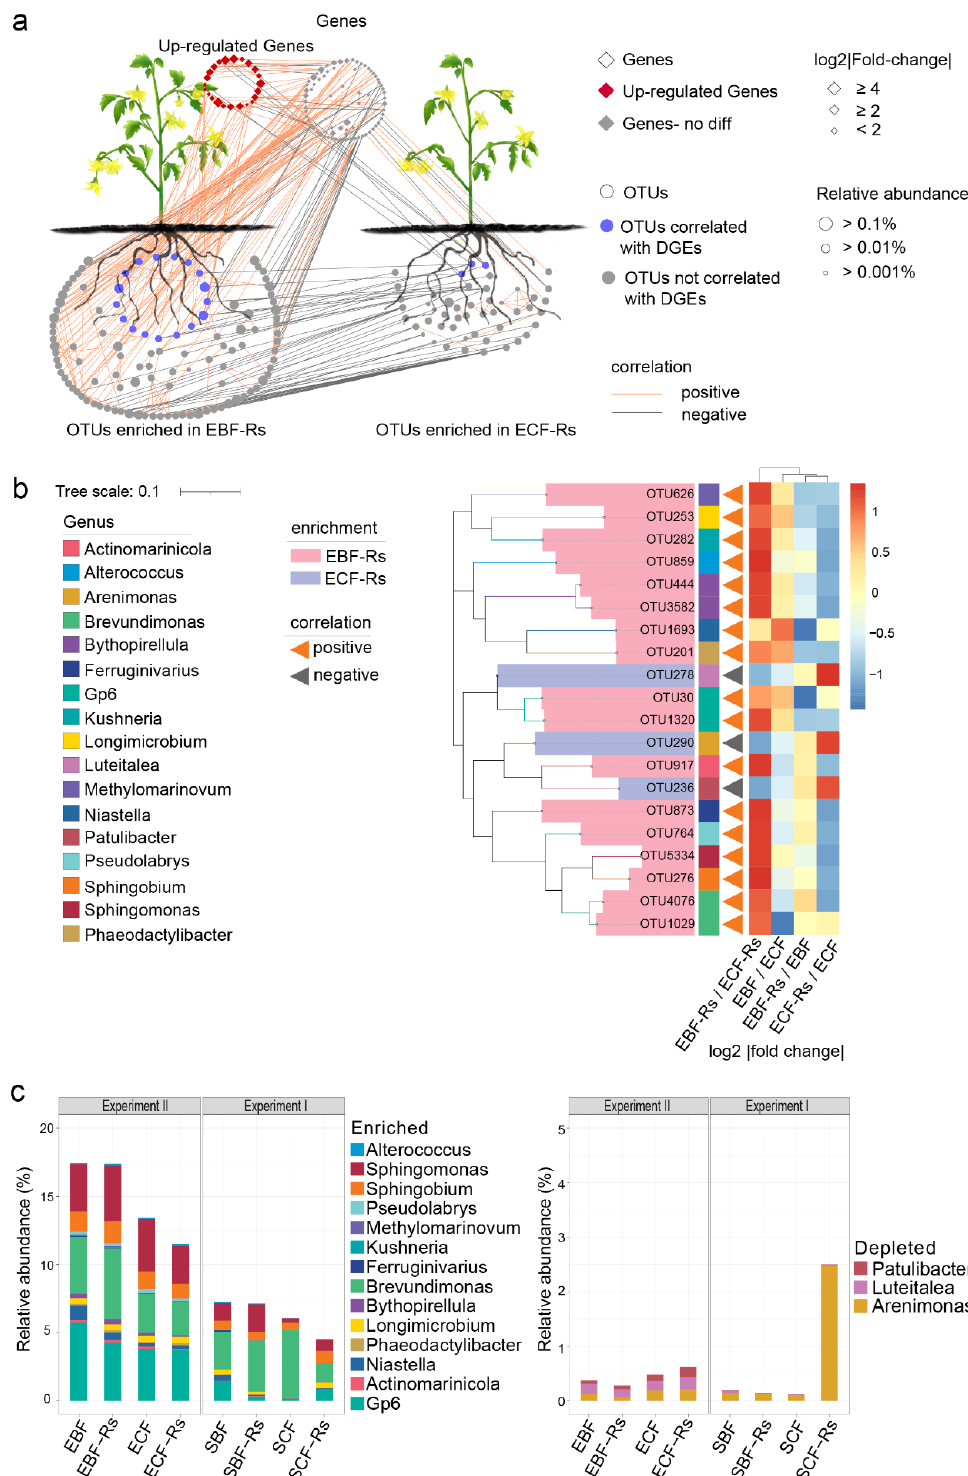
Figure 5. Correlational analysis between microbial taxa and root gene expression. ( a ) Network analysis displays all possible correlations between OTU × OTU, OTU × gene, and gene × gene (all 143 genes in phenylpropanoid biosynthesis pathway and all enrichment OTUs in EBF ‐ Rs (139) and ECF ‐ Rs (68), Spearman’s correlation coefficient ( r ) > 0.6 and statistically significant ( p ‐ value < 0.05); ( b ) OTUs significantly correlated with DEGs, the heatmap displays the relative change (fold change) of OTUs between the two treatments; ( c ) Relative abundances of specific genera in the two